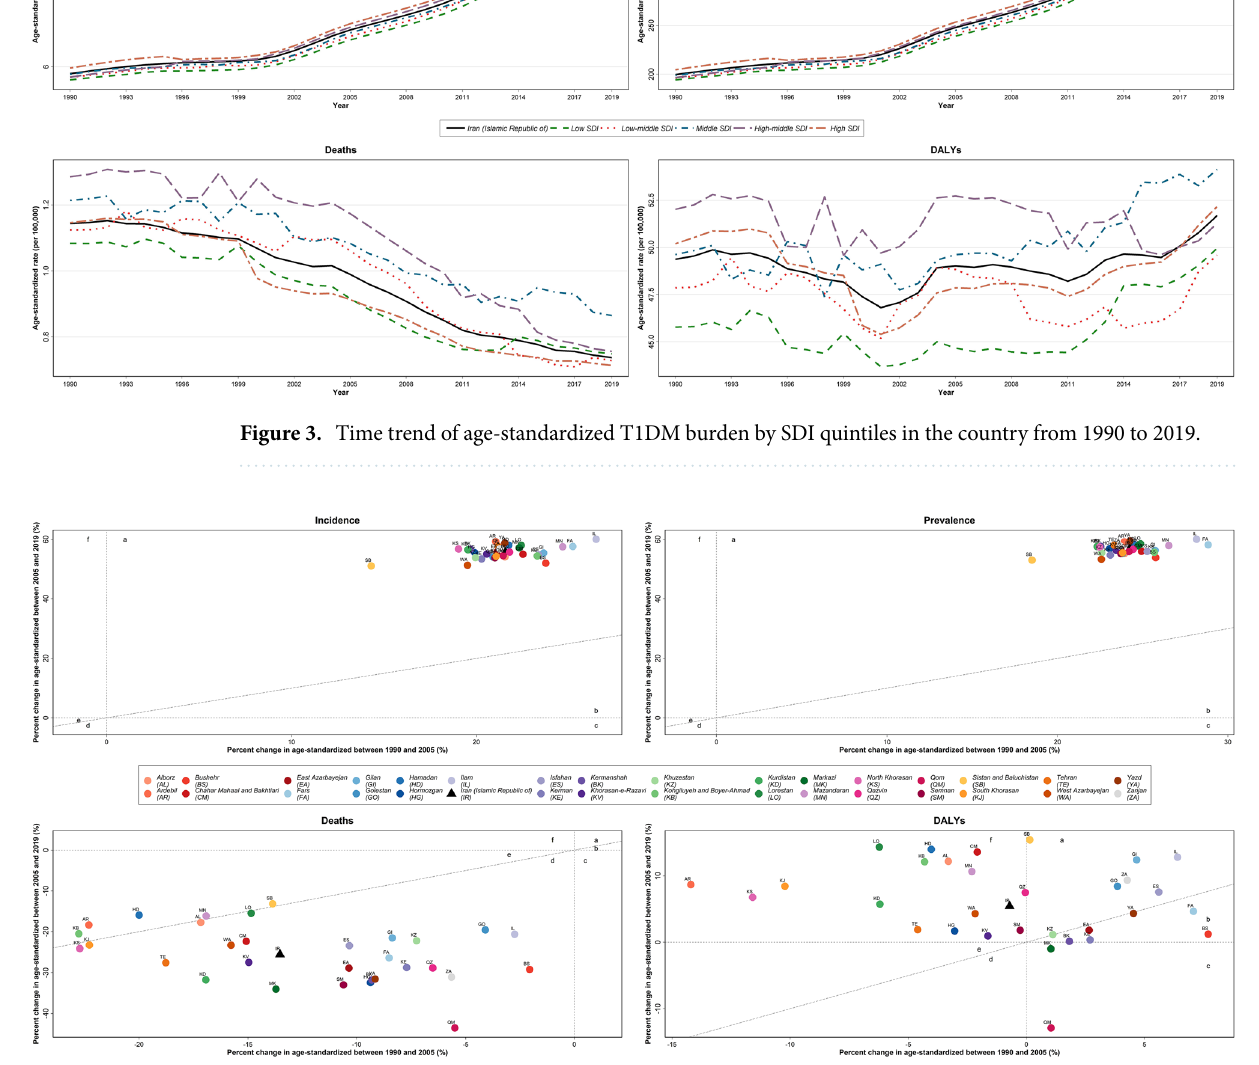
Figure 4. National and sub-national percent change in the age-standardized burden of T1DM in 1990–2005 compared to 2005–2019 ( a ), rates increased more rapidly after vs before 2005. ( b ) Rates increased more slowly after vs before 2005. ( c ) rates increased before 2005 but decreased after 2005. ( d ) rates decreased more rapidly after than before 2005. ( e ) rates decreased more slowly after than before 2005. ( f ) rates decreased before 2005 but increased after